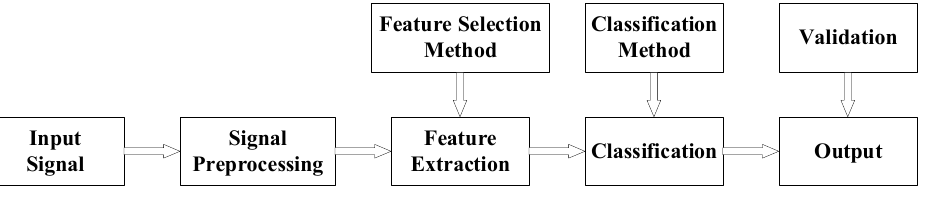
Figure 10. Process of emotion recognition method.